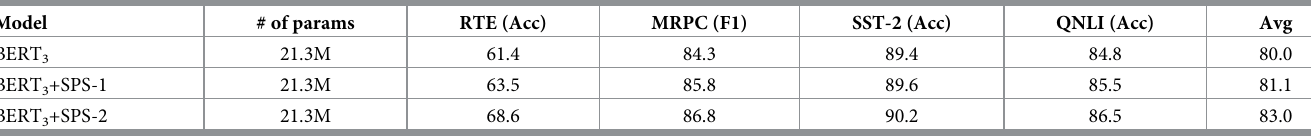
The results are derived using GLUE dev set.